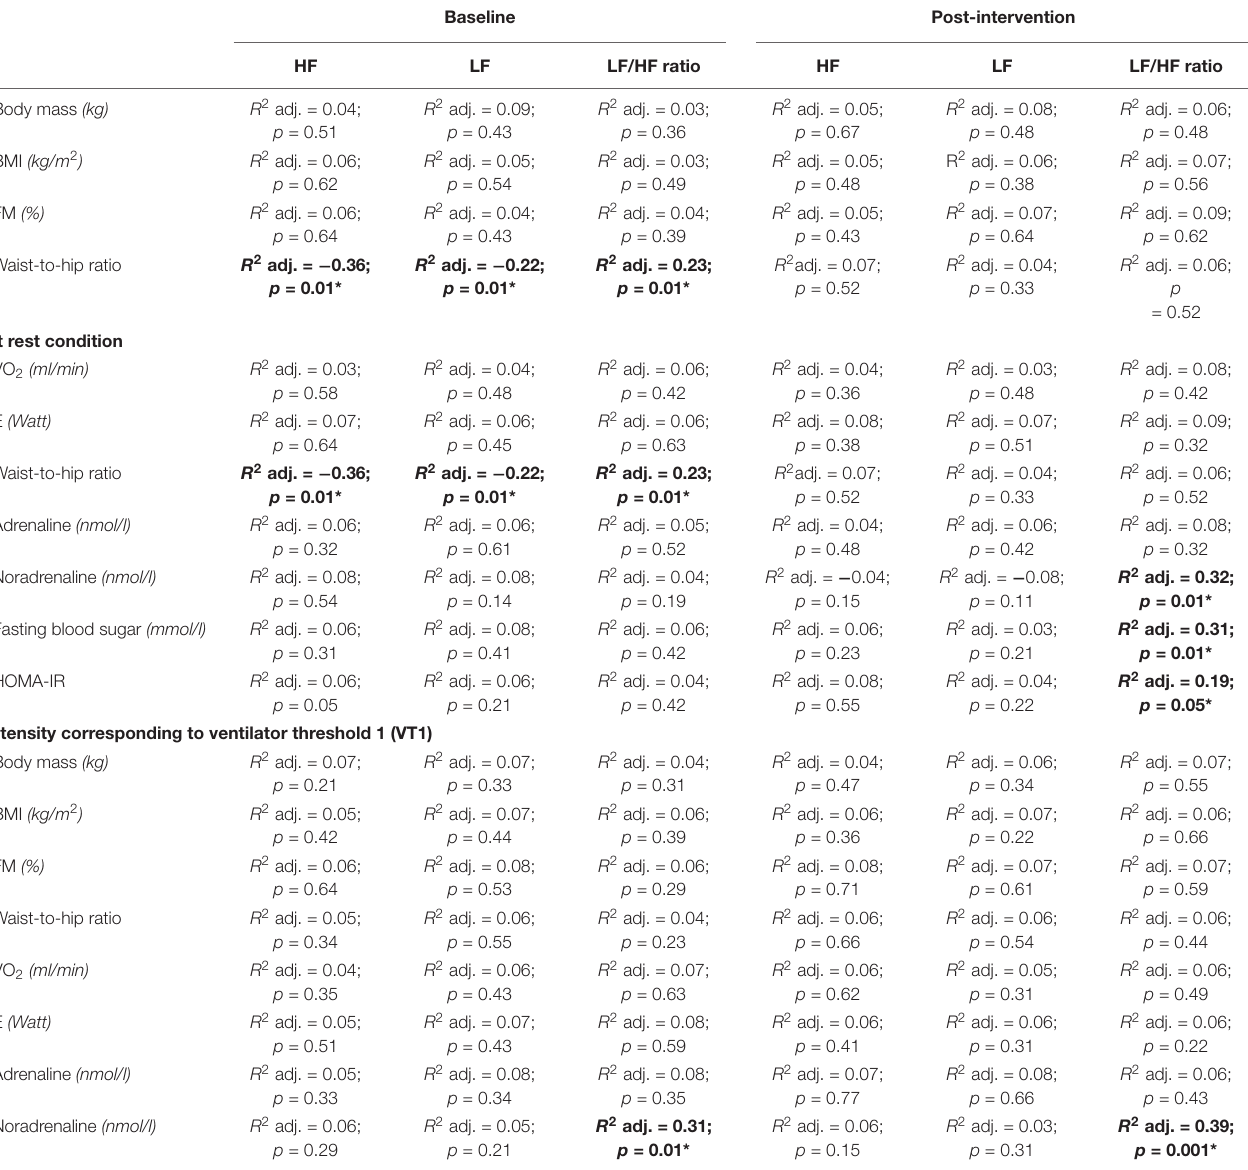
TABLE 3 | Standardized regression summary between frequency domain markers and anthropometric, fitness and biochemical variables in both groups.